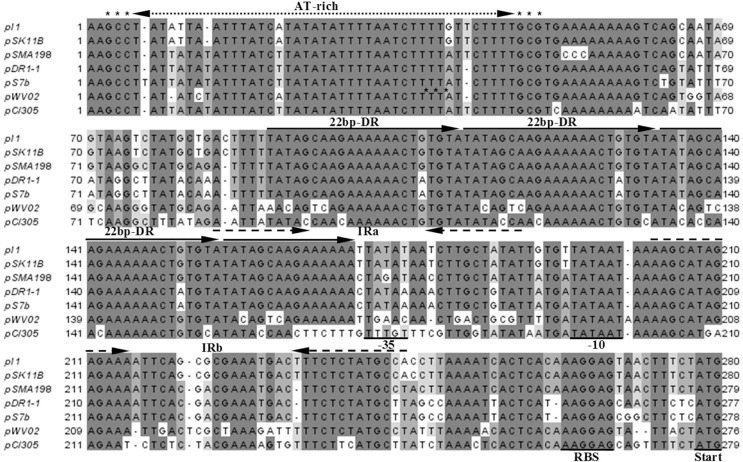
Multiple sequence alignment of ori of pSMA198 and its related plasmids.The alignment was performed using ClustalW [23]. Arrows indicate the position of the AT-rich region, the 22-bp direct repeat (DR) iterons and two inverted repeats (IR). The predicted leader region (−35, −10 and the RBS) and the start codon of the rep gene are underlined.